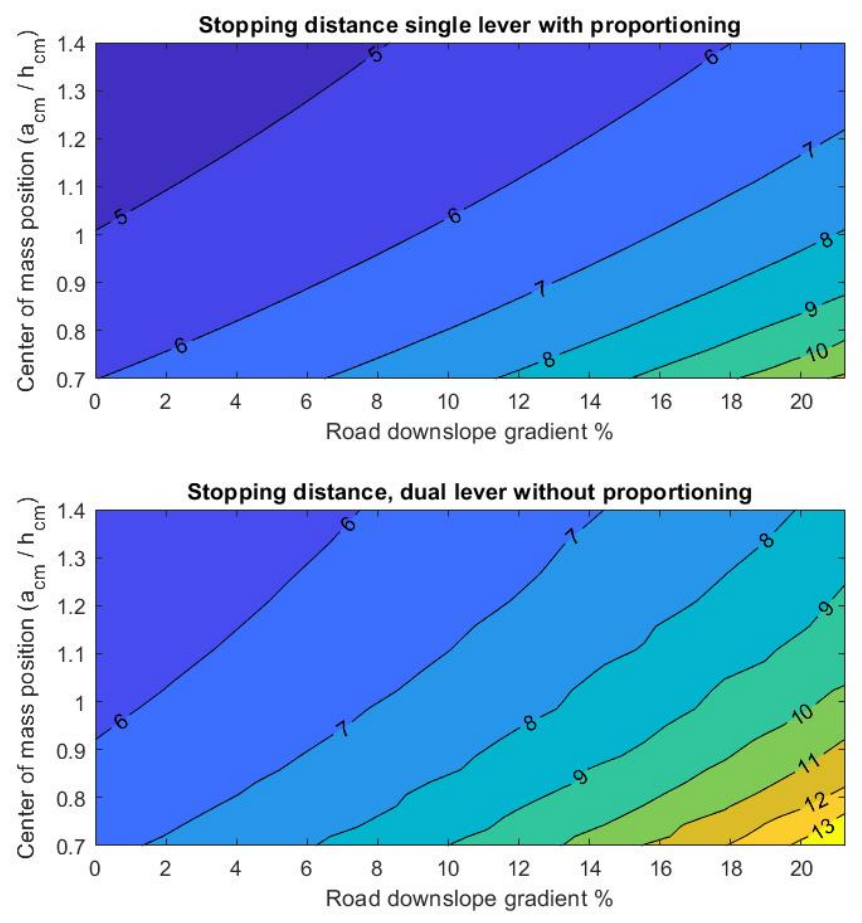
Figure 13. Simulated stopping distance without wheel-lock (m) from 25 km/h for a 100 kg bike and rider system comparing the single-lever, prototype proportioning brake system versus a dual-lever brake system.